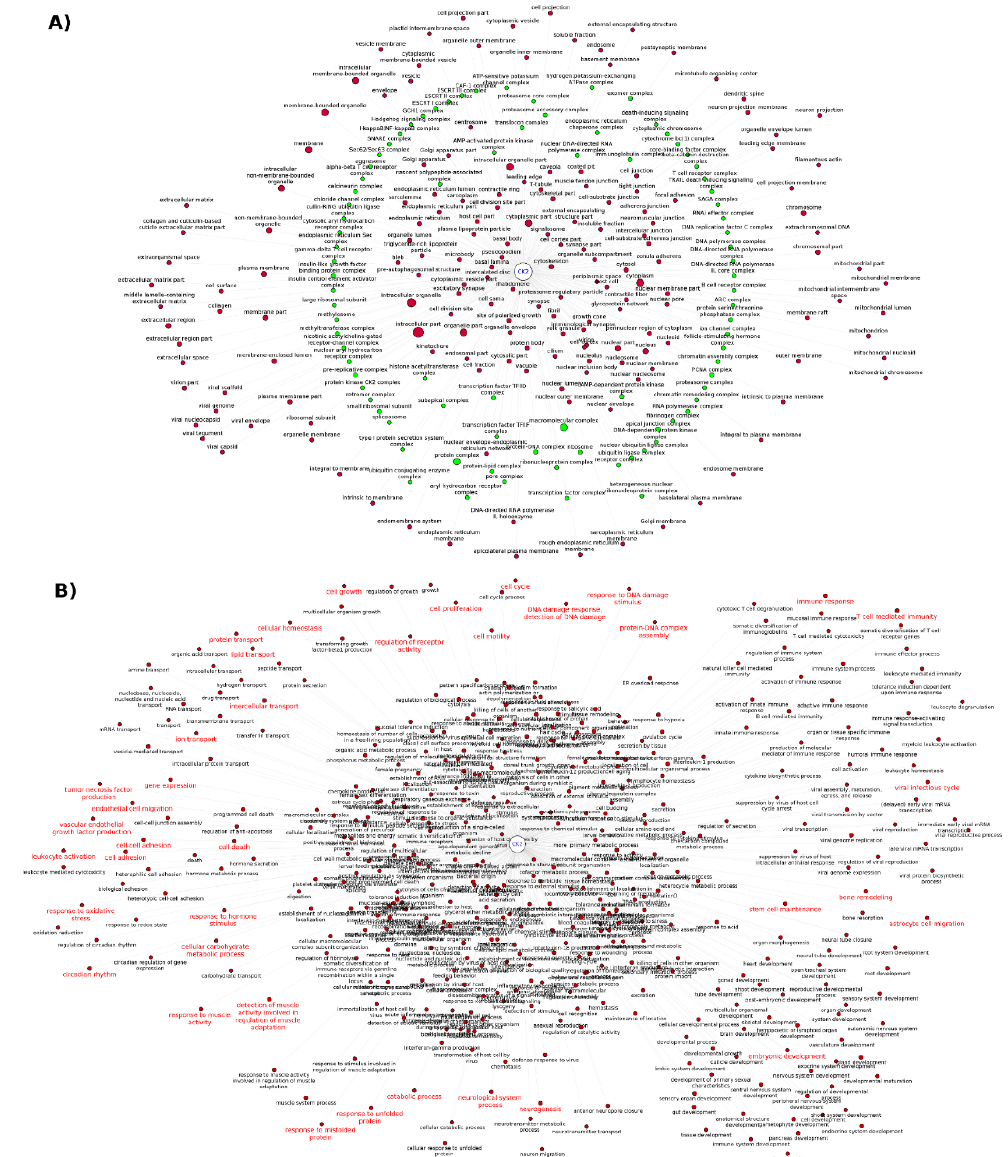
Figure 3. CK2 Functional association networks represented in Cytoscape v3.4.0 for illustrating the: ( A ) Cellular components mentioned together with CK2 in the literature identified by GoPubMed search. The green nodes represent protein complexes and the node size highlights terms frequently co-occurring with CK2; ( B ) Biological processes mentioned together with CK2 in the literature identified by GoPubMed search; the red label-nodes indicate hot topics in CK2 research. Briefly, the term “Casein Kinase II”[Mesh] was queried using the GoPubMed text mining tool and the output was downloaded to generate a network in SIF format [61] for Cytoscape input by specifying CK2 and the GO subcellular components/biological processes as nodes and their co-occurrence in the literature as the interactions (binary type: yes/no). The node size was not set differentially for the biological processes network as this will affect the visualization and readability. A high resolution image of this figure is also available in the Supplementary Materials.